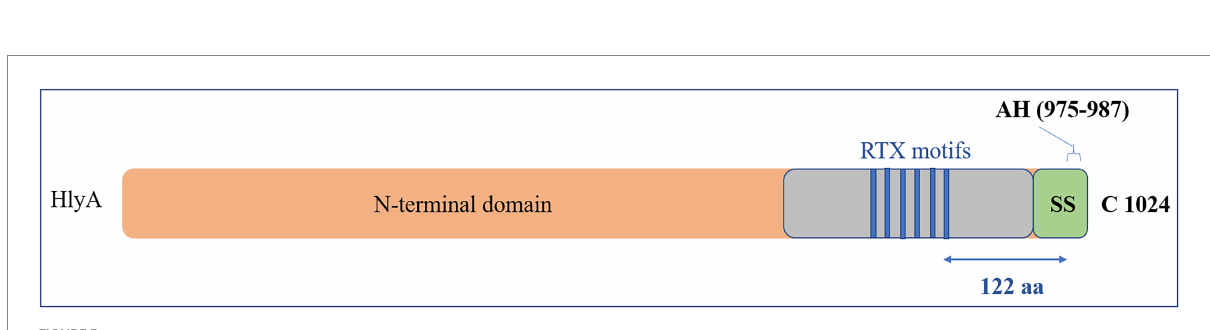
FIGURE 5 Schematic view of the HlyA and HlyA2. The distance the last C-terminal RTX and the beginning of the AH is 122 residues (122*3.8 Å = 463.6